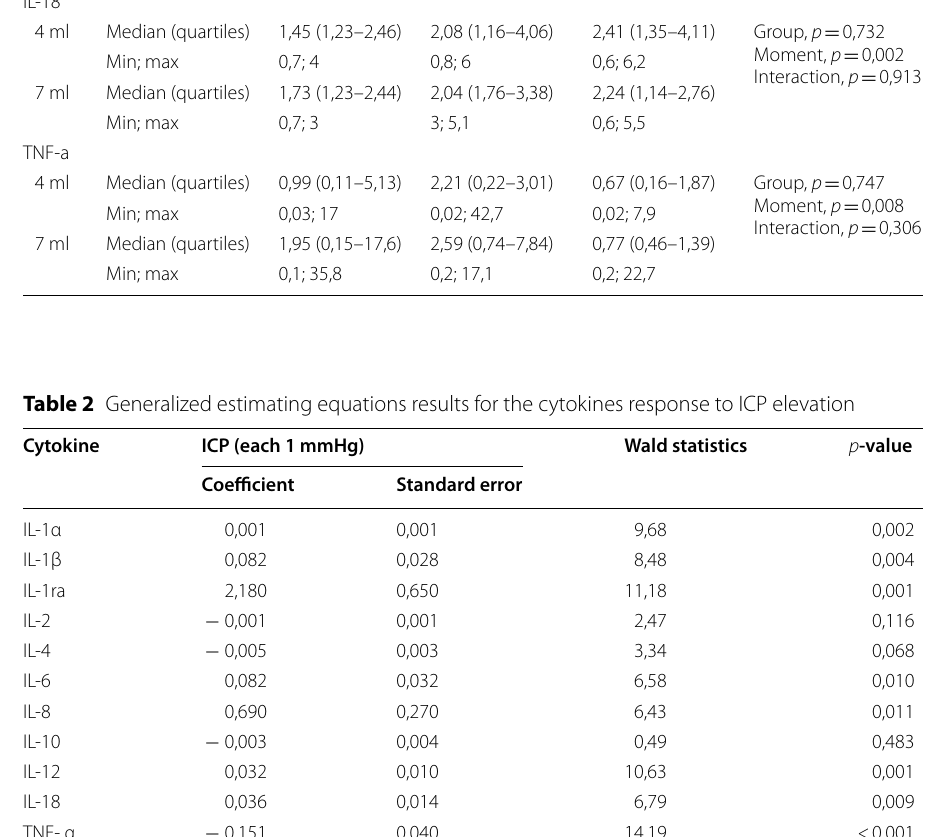
Table 3 Cytokines standardized ( z -score) mean variation along the experiment (reference: baseline)